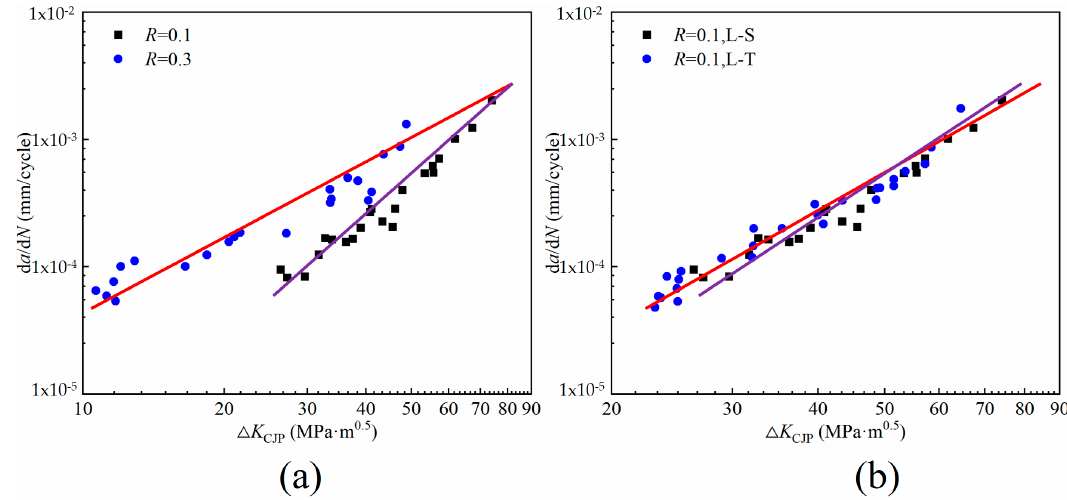
Figure 14. Data of FCG rate. ( a ) The crack growth rate of specimens selected from the L–T direction under different stress ratios, ( b ) the crack growth rate of specimens at different orientation under the same stress